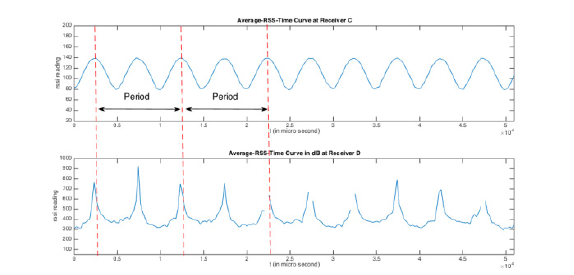
Fig. 7. Period of Average-RSS-Time